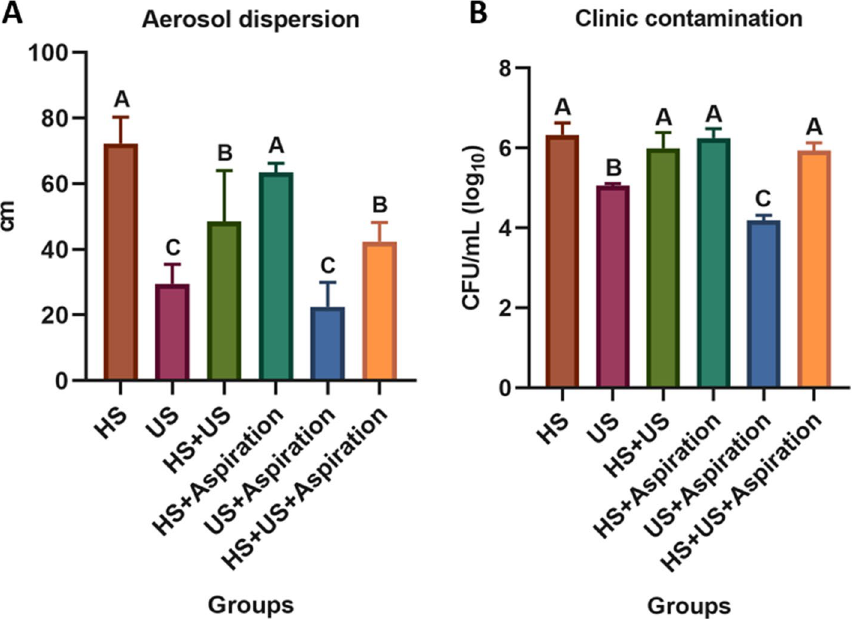
Figure 3. ( A ) Measurement of the distance in centimeters reached by the aerosol produced by introducing red dye to the AR and US water system; ( B ) Bacterial growth (CFU/mL) produced by the aerosol by introducing the inoculum into the AR and US water